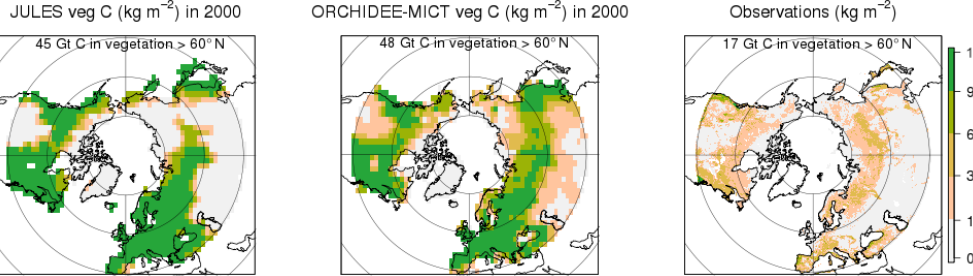
Figure 2. Simulated vegetation carbon distribution for JULES and ORCHIDEE-MICT for the year 2000, and the observations from the IPCC Tier-1 Global Biomass Carbon Map again for the year 2000